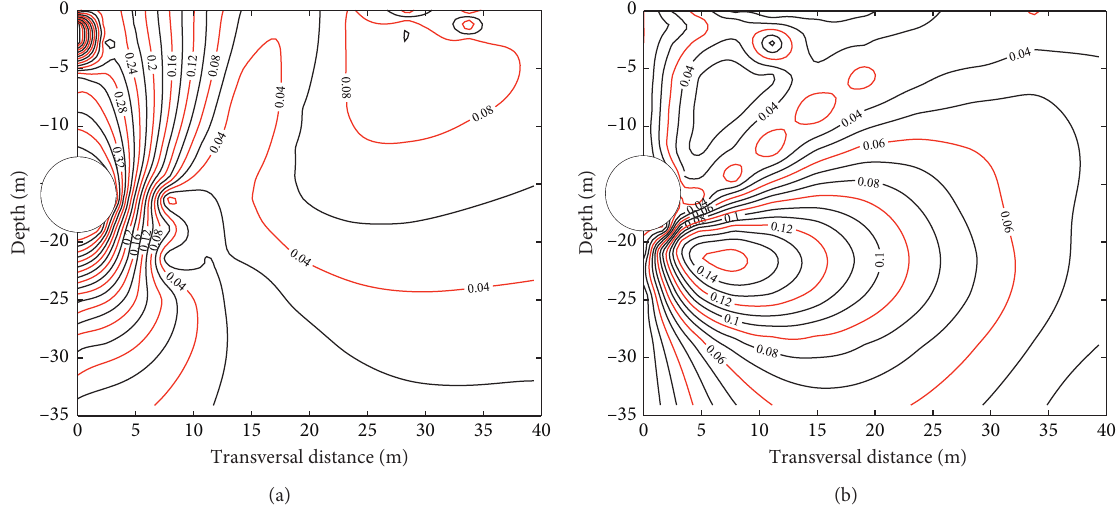
Figure 26: Displacement contour of the soft ground: (a) vertical direction; (b) transversal direction.